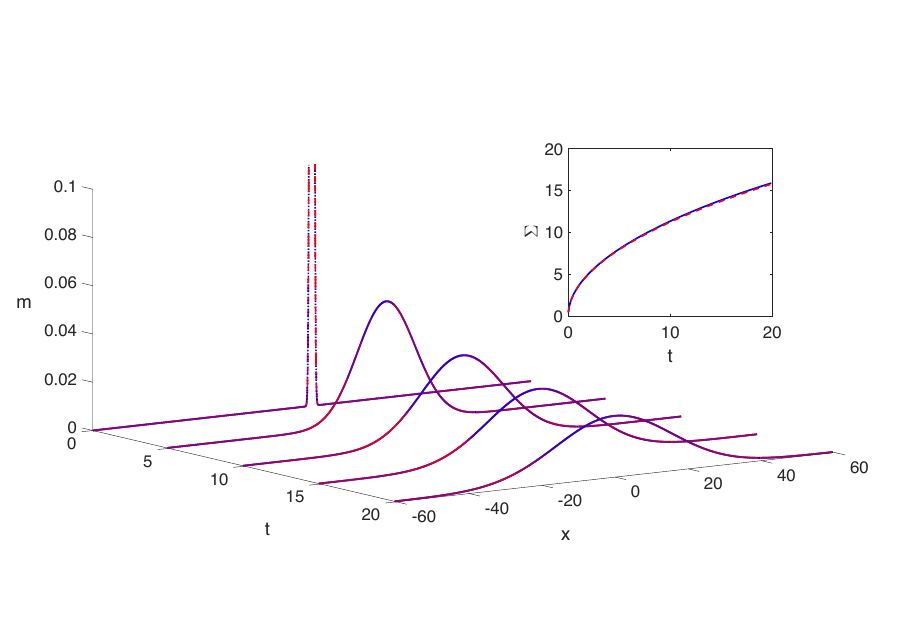
Figure 3: Computational solution of the Gross-Pitaevskii equation (blue dot) and variational Ansatz (red dashed). The inset shows the time evolution of the numerical variance (full) and Σ as defined in Eq. (47). In this case g = − 2, σ = 3.5, µ = 1 and T =